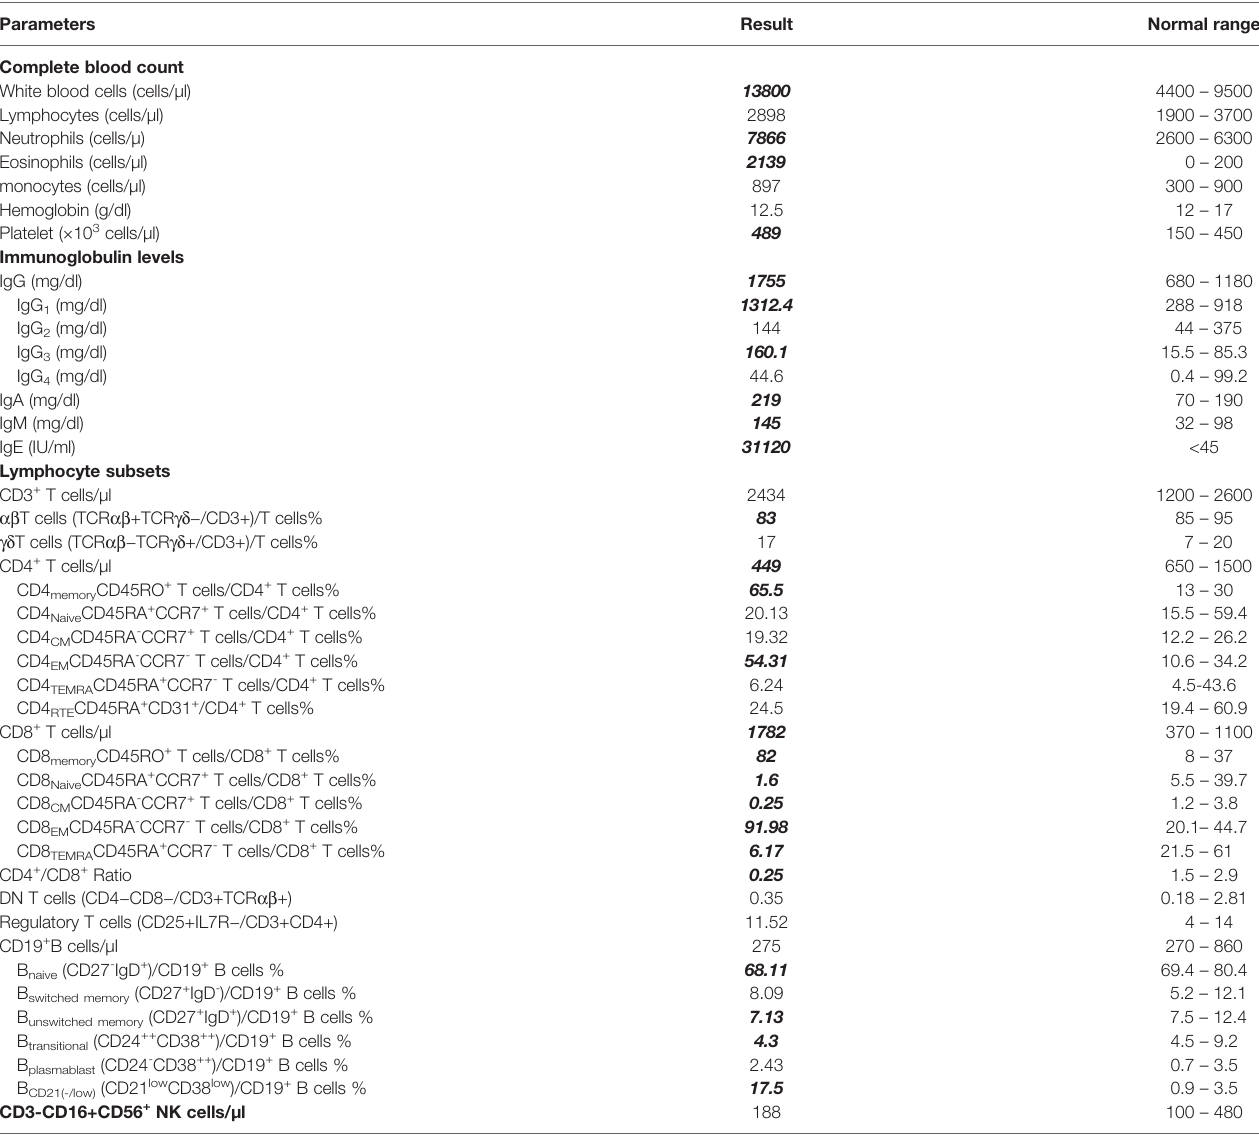
TABLE 1 | Immunologic characteristics of the patient with hypomorphic/atypical X-SCID.